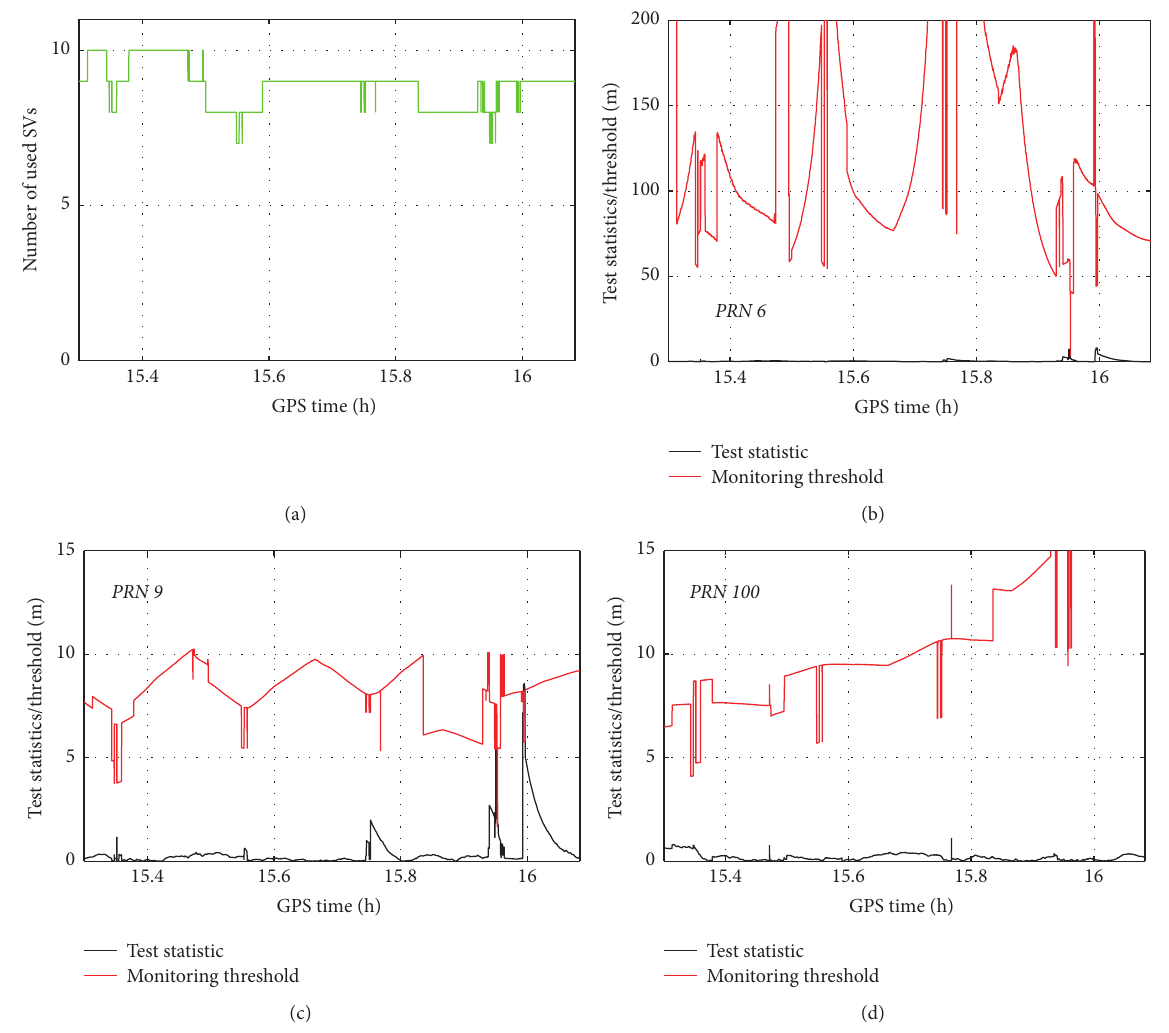
Figure 7: Test statistic and monitoring threshold for three example